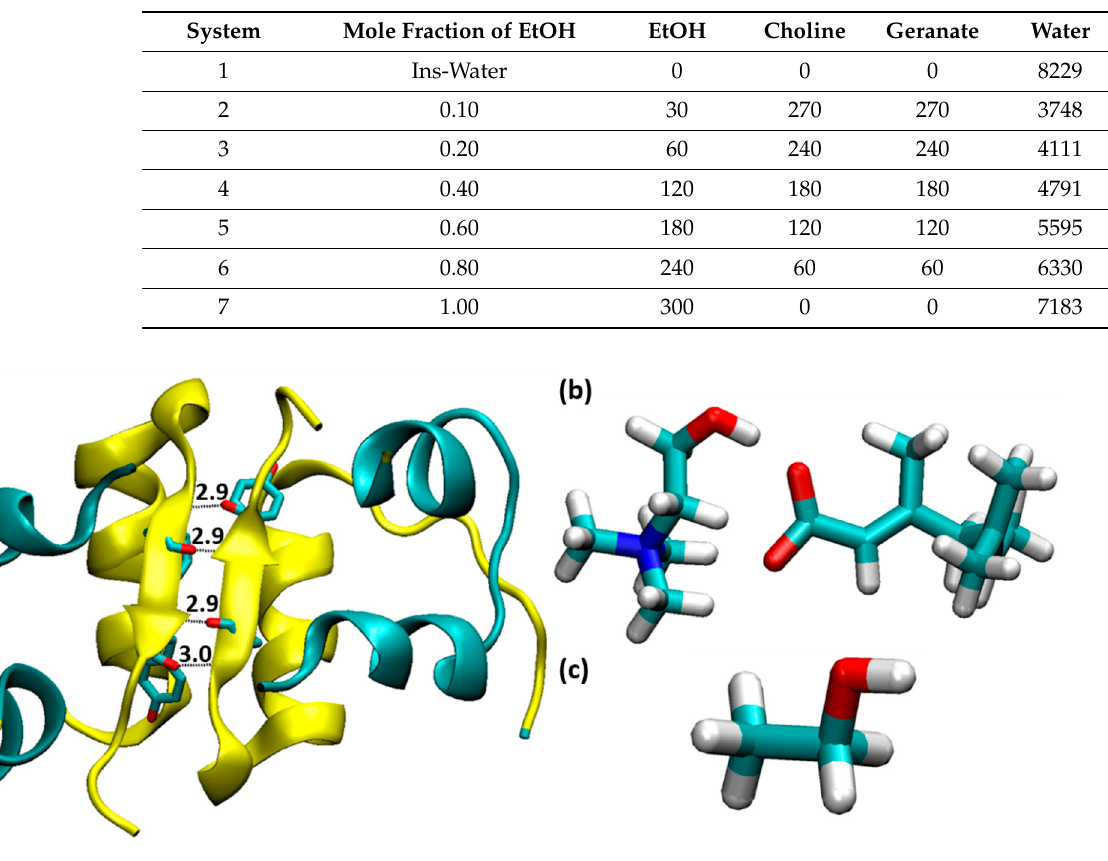
Figure 1. ( a ) The structure of insulin dimer, where chains A, C and B, D are indicated by cyan and yellow color, respectively (four H-bonds between Phe B24 and Tyr B26 ). ( b ) choline geranate IL and ( c ) ethanol molecule.